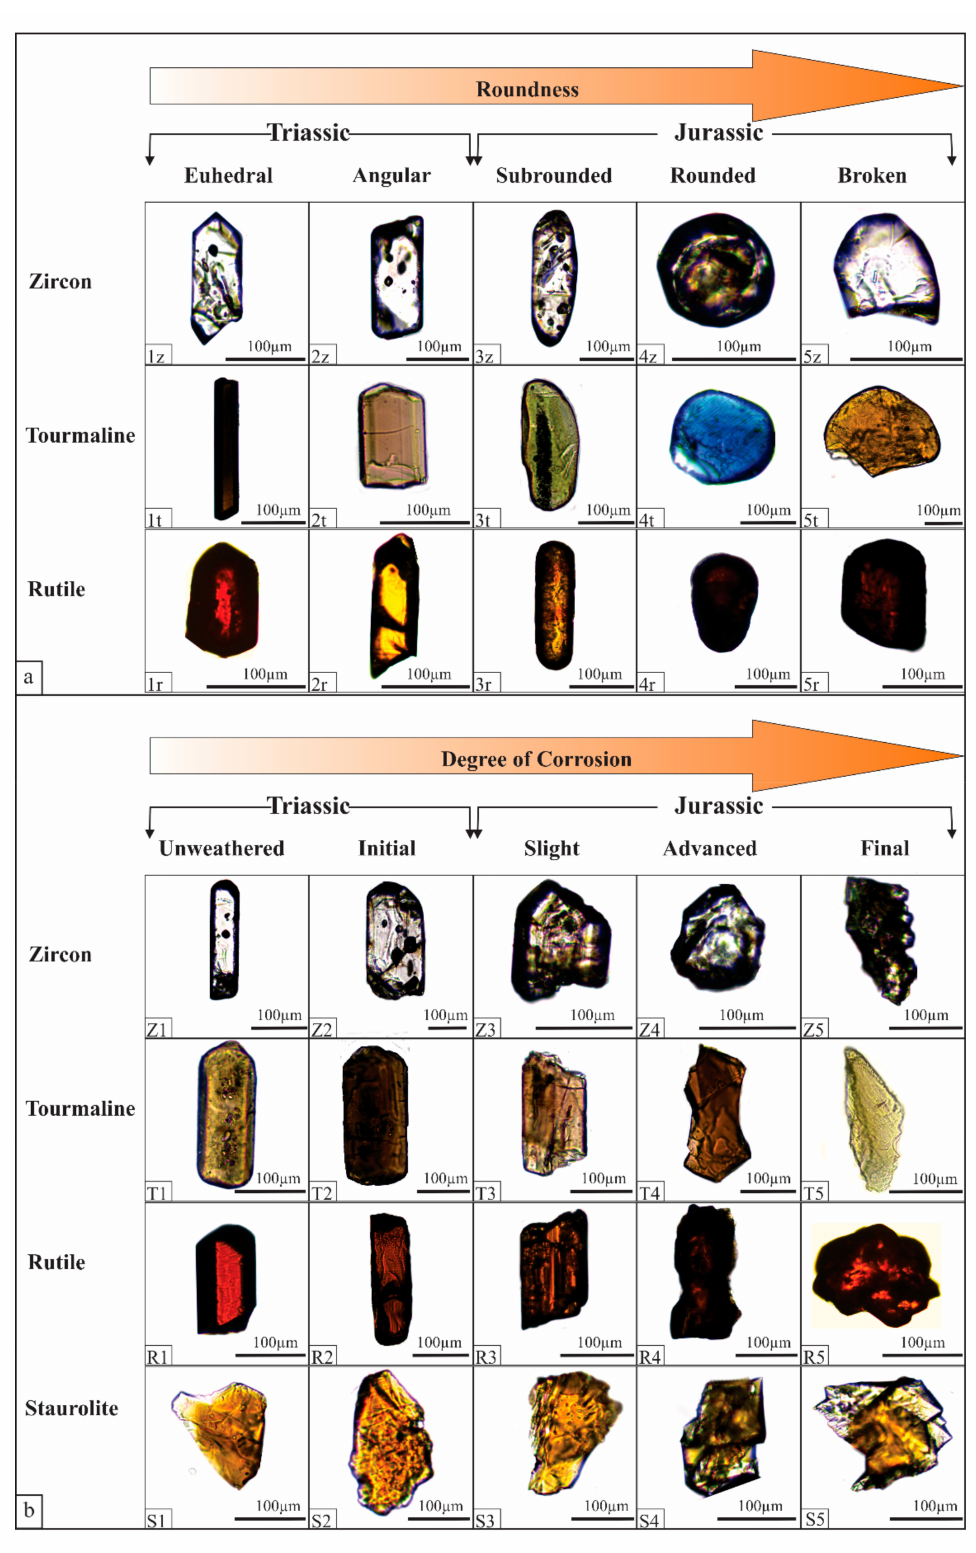
Figure 13. ( a ) Representative heavy minerals plotted in order of increasing degree of roundness from left (euhedral) in Triassic strata to right (broken) in Jurassic strata at Kasanwala, ( b ) representative heavy minerals indicating an increasing degree of corrosion from left (unweathered stage) in Triassic strata to right (extreme stage) in Jurassic strata at